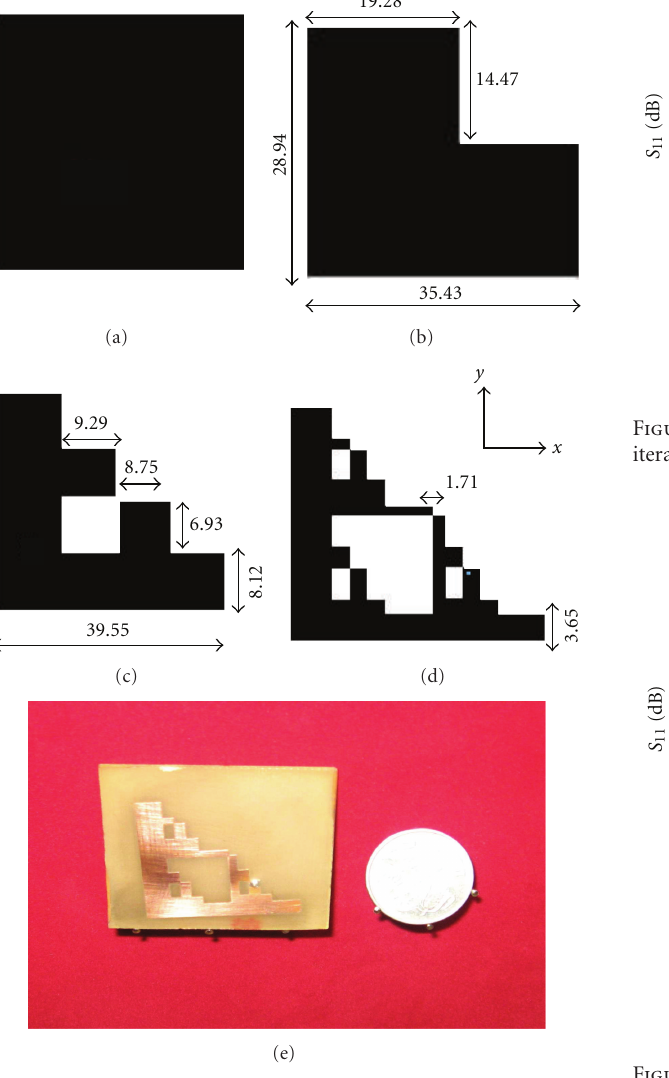
Figure 4: Performance comparison between initiator (S1), first iteration (S2), and second iteration (S3).